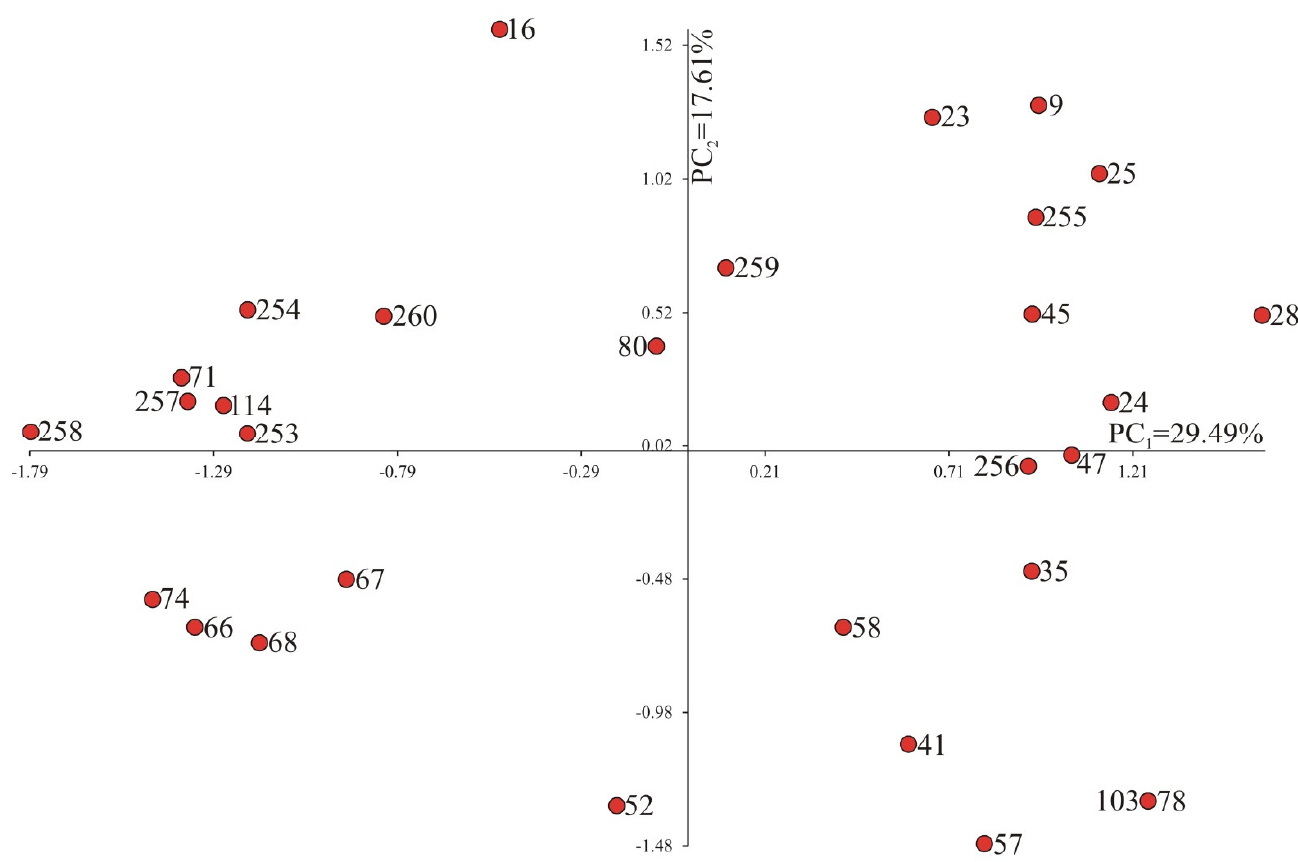
Figure 7. Electrophoretic image of PCR products after including bnlg1621 and umc2059 primer pairs in the reaction.